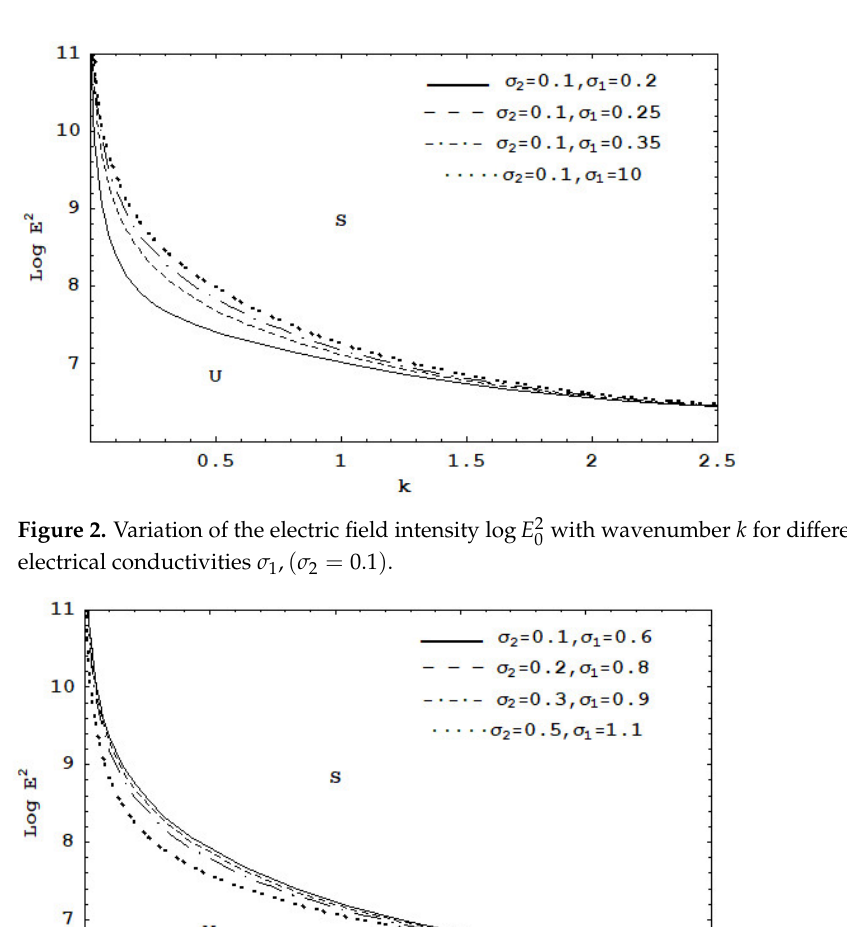
Figure 3. Variation of the electric field intensity log E 2 electrical conductivities σ 1 , σ 2 , ( σ 1 > σ 2 )